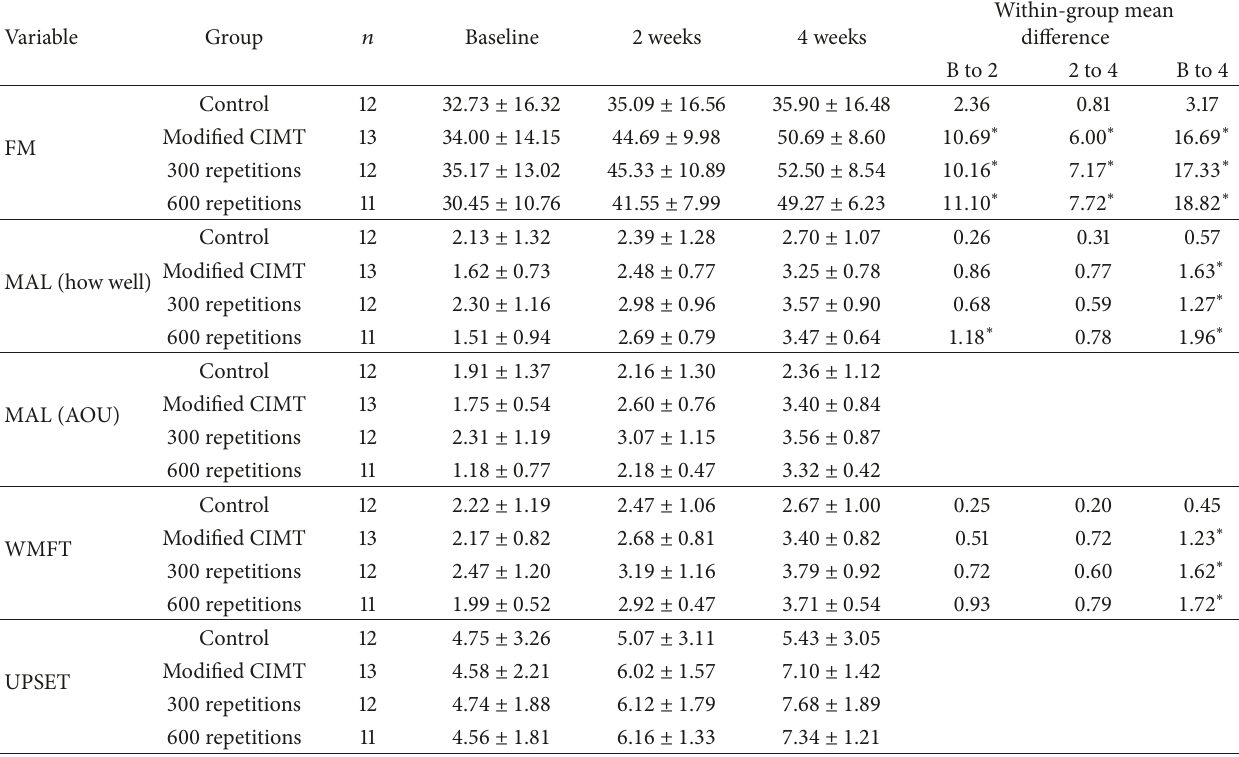
Table 2: Groups’ mean scores at baseline, 2 weeks, and 4 weeks after intervention in the outcomes of interests. Variable